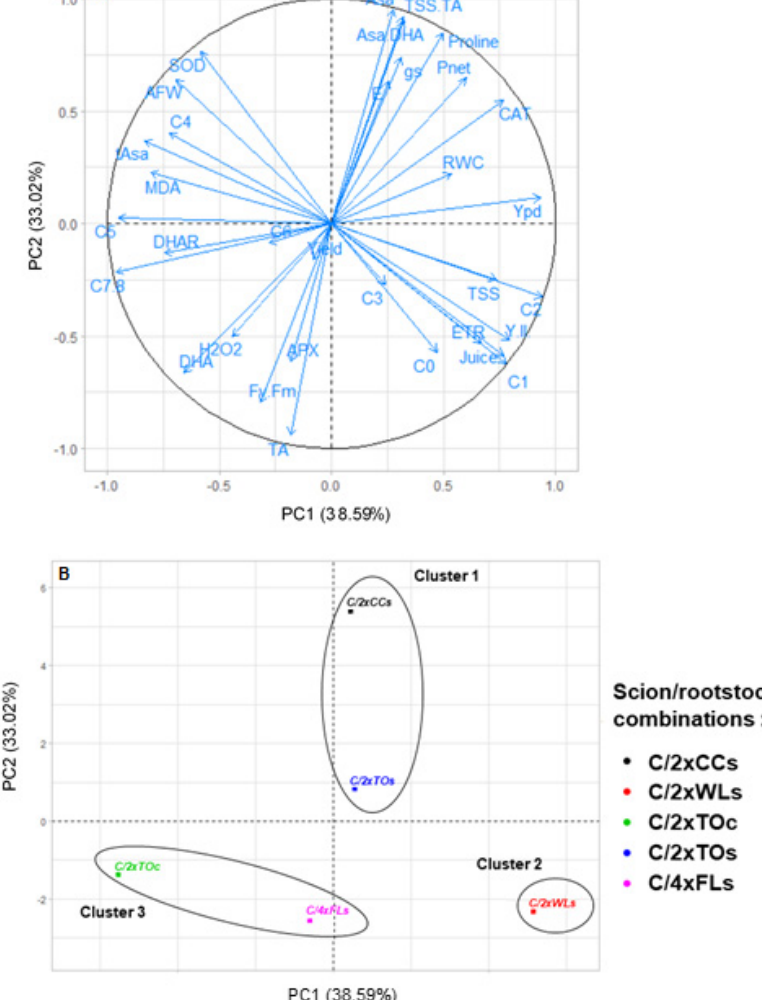
Figure 5. Biplot obtained from principal component analysis (PCA) performed with all the parameters studied after 40 days of water deficit on clementine trees grafted onto different rootstocks. The tested rootstocks were trifoliate orange cutting (C/2xTOc), trifoliate orange seedling (C/2xTOs), Carrizo citrange (C/2xCCs) and Willowleaf mandarin (C/2xWLs) diploids and FlhorAG1 an allotetraploid somatic hybrid (C/4xFLs). Dispersion of scion/rootstock combinations ( A ) and contribution of the variables to the dispersion ( B ).